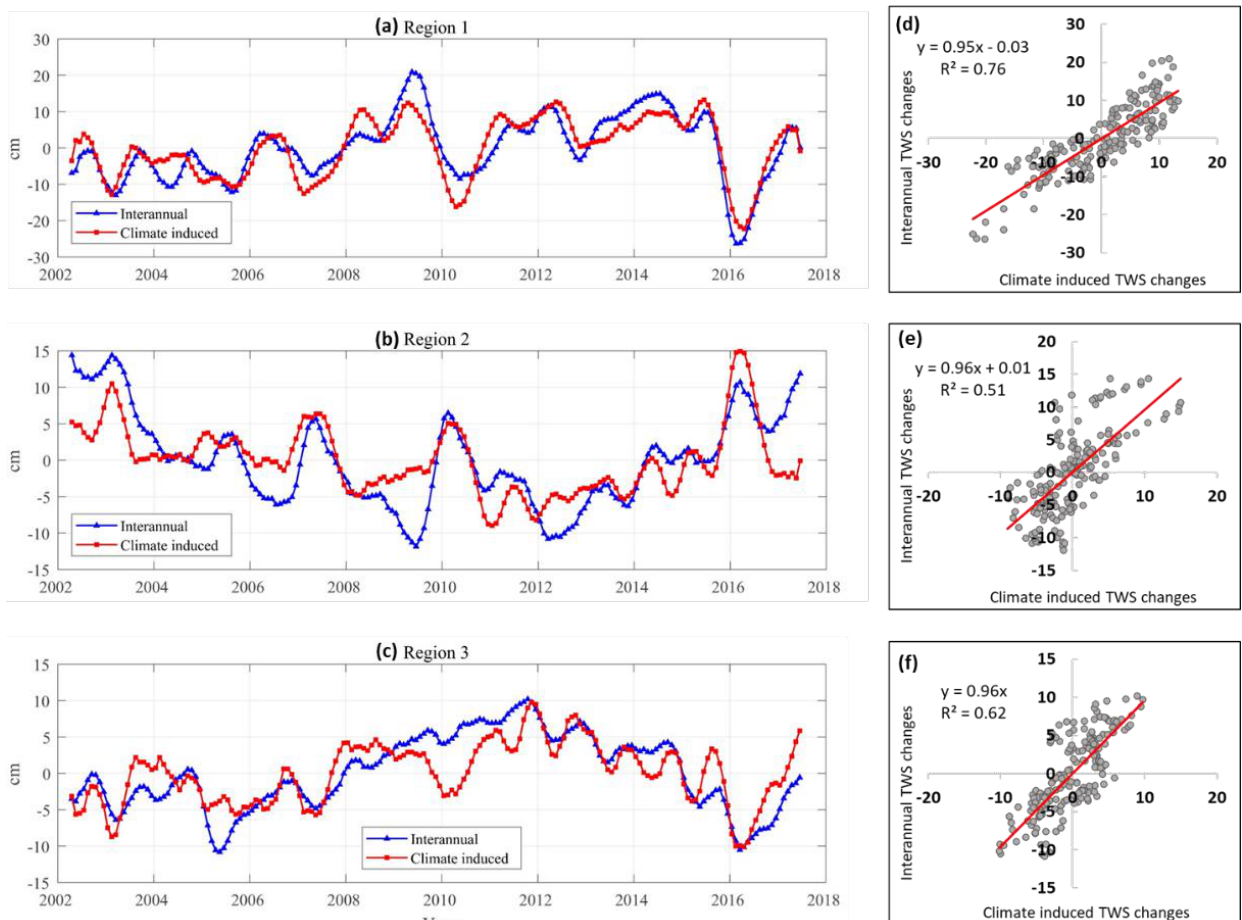
Figure 6. The interannual and climate induced TWS changes from GRACE SH solutions in the three selected regions shown in Figure 3a. ( a – c ) show the interannual TWS changes (blue curves) and climate induced TWS changes (red curves) for Regions 1–3. ( d – f ) show the corresponding linear fitting relationship between the two curves in the three regions.